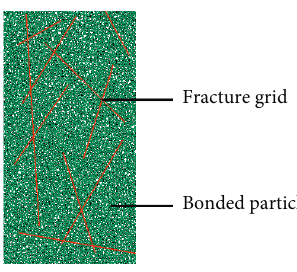
Figure 3: Particle flow model of the